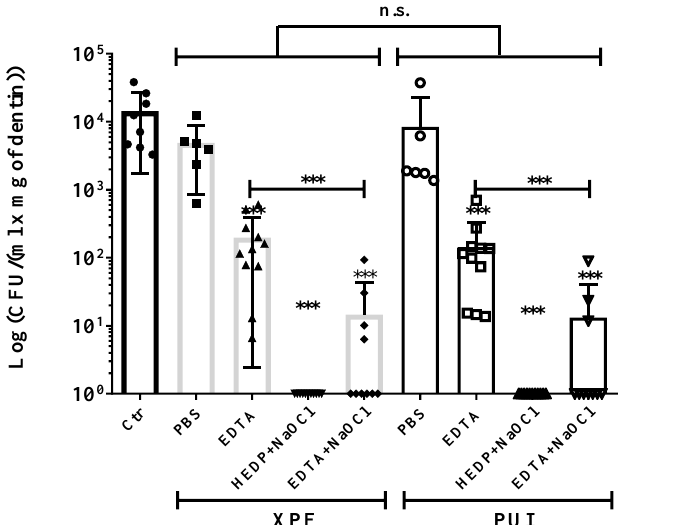
Figure 3. Quantification of E. faecalis remaining in root canals after different file and irrigant treat- ments. Above : Classification of the different groups and subgroups used in the study. Below : Dental roots incubated for 2 weeks in the presence of E. faecalis were treated as indicated for 1 min. Dentin from root canals was recovered and used to quantify remaining bacteria. Control (black bar) untreated group is compared to XP-Endo finisher (XPF) (grey bar) and passive ultrasonic activation (PUI) (white bar) file treatments together with the indicated irrigants *** p < 0.001; n.s. (non-significant differences): p > 0.01. Table 1. Mean and exact p values obtained from the comparison of the indicated experimental groups with the control (untreated group). Mean and p value numbers correspond to Figure 3. Numbers were obtained by Kruskal–Wallis statistical analysis. No differences were appreciated between XPF and PUI. Ethydronic acid (HEDP) irrigation had the highest effect in eliminating bacteria with respect to the control